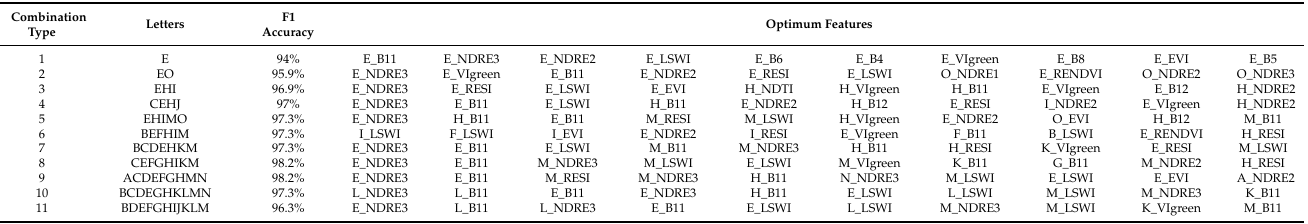
Table A7. Top-10 optimal corn feature sets for different combination types on 7 July